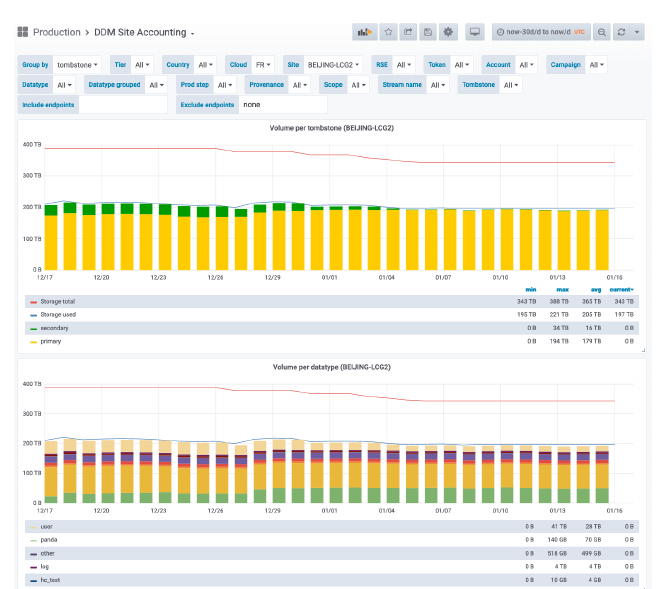
Figure 3. Overview of the DDM Site Accounting Dashboard